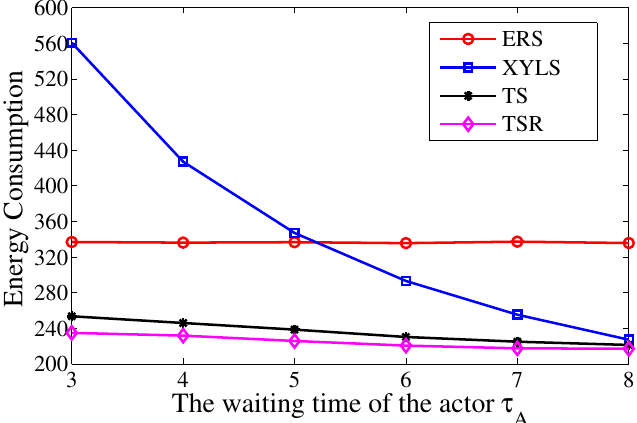
Figure 8. The energy consumption over the waiting time of actor τ A